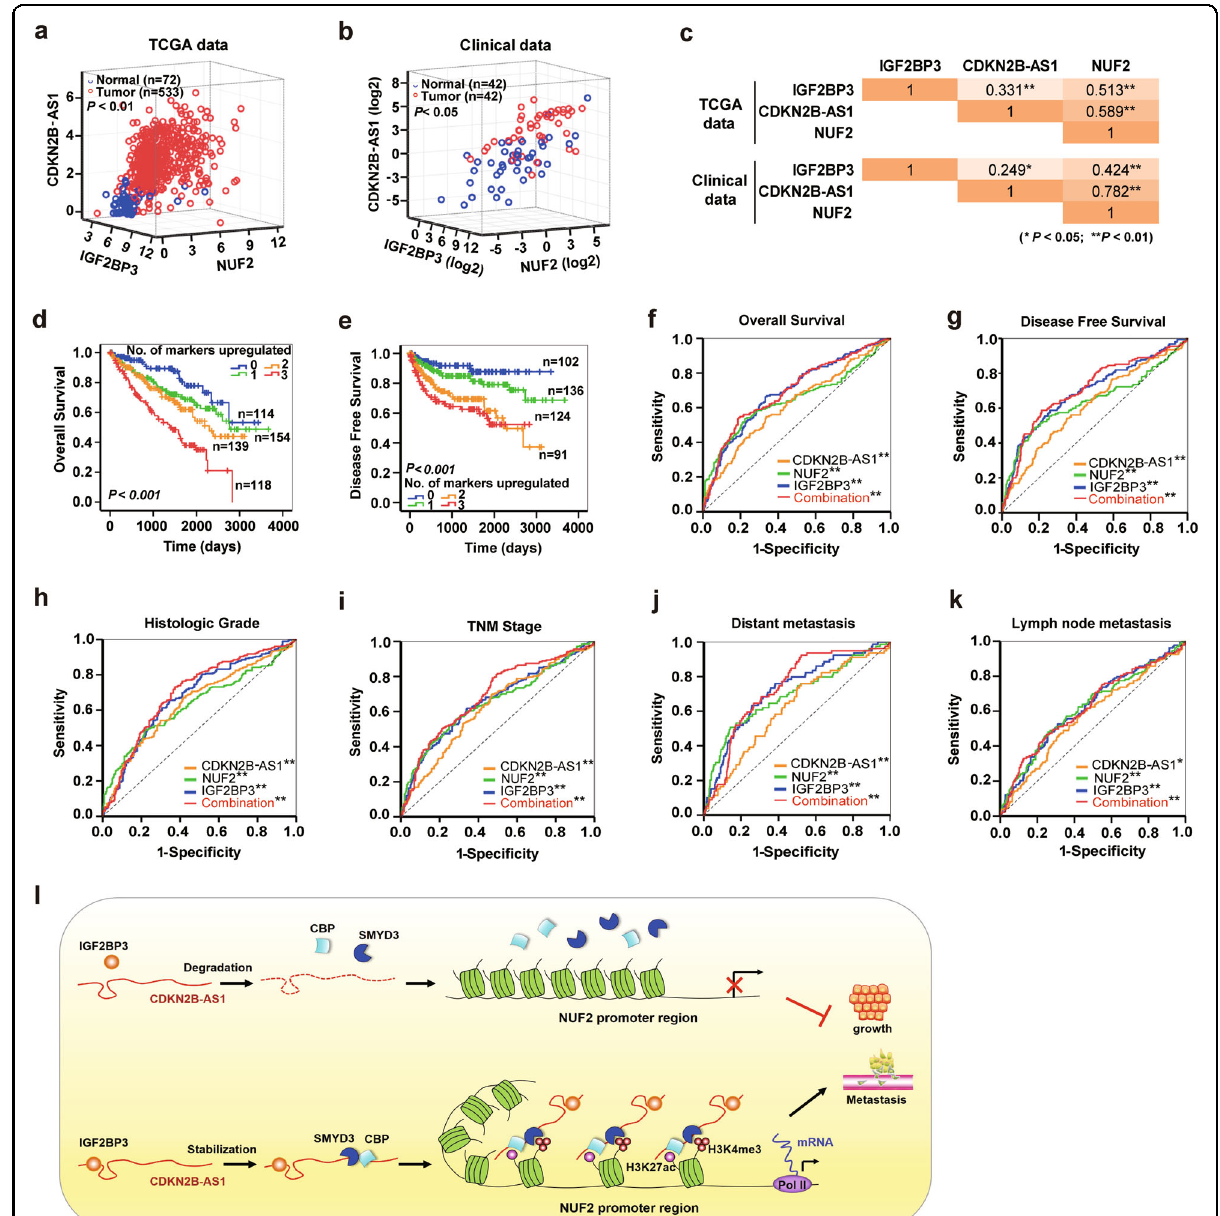
Fig. 6 IGF2BP3/CDKN2B-AS1/NUF2 axis is an attractive candidate as a prognostic and diagnostic biomarker of KIRC. a – c Pearson correlation analysis of the relationship between CDKN2B-AS1, IGF2BP3, and NUF2 levels in TCGA-KIRC dataset ( a ) and 42 paired KIRC tissues and adjacent normal tissues ( b ), normal tissues are shown as blue circles and tumor tissues as red circles; the correlation coef fi cient between each two markers is shown in c . d , e Kaplan – Meier analysis of overall survival and disease-free survival for KIRC patients in TCGA dataset based on the number of upregulated molecular markers; CDKN2B-AS1, NUF2, and IGF2BP3 expression was strati fi ed by the individual medians by RNA-seq data, and the patients were divided into four groups as indicated. f , g ROC curve analysis of overall survival ( f ) and disease-free survival ( g ) for CDKN2B-AS1, NUF2, and IGF2BP3 as individual biomarkers or as a combined panel (containing CDKN2B-AS1, NUF2, and IGF2BP3). h – k ROC curve analysis for CDKN2B-AS1, NUF2, and IGF2BP3 as individual biomarkers or as a combined panel to discriminate KIRC patients with high tumor grades (G3 and G4) from those with low tumor grades (G1 and G2) ( h ); KIRC patients with stages III and IV from those with stages I and II ( i ); KIRC patients with distant metastasis from patients without distant metastasis ( j ), and KIRC patients with lymph node metastasis from patients without lymph node metastasis ( k ). ** p < 0.01, * p < 0.05. l Schematic diagram of the IGF2BP3/CDKN2B-AS1/NUF2 axis regulating tumor growth and metastasis in KIRC cells. CDKN2B-AS1 is stabilized by speci fi cally binding to IGF2BP3 and acts as a modular scaffold of the CBP and SMYD3 epigenetic-modifying complex to increase H3K27ac and H3K4me3 modi fi cation in the promoter region of NUF2 , thereby enhancing NUF2 transcription, and promoting tumor cell growth and